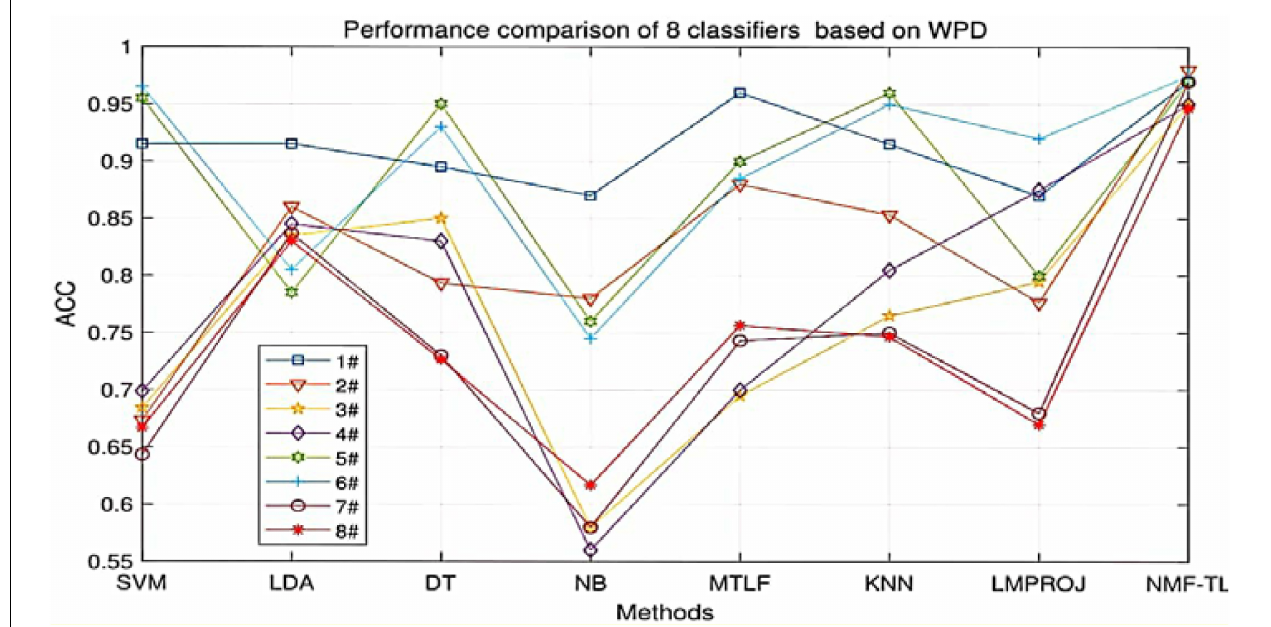
FIGURE 4 | Classification accuracy comparison of 8 classifiers on datasets based on WPD feature